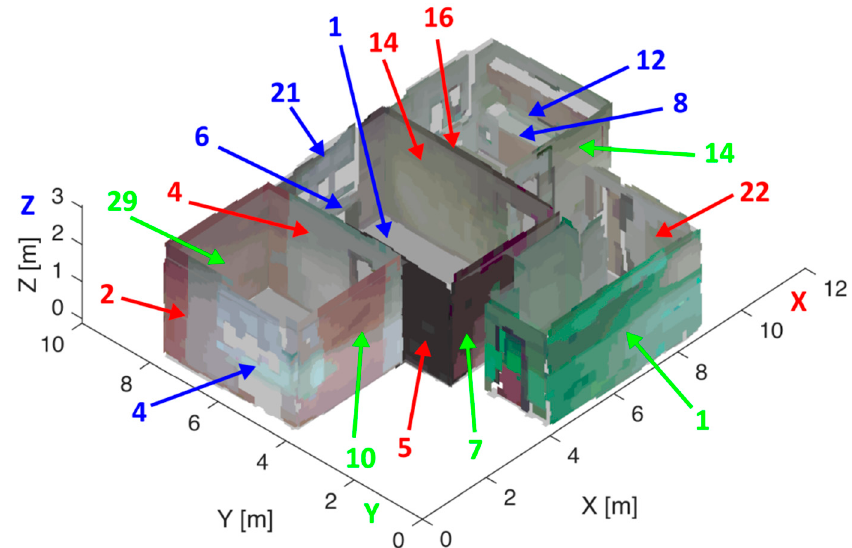
Figure 19. Flat visualization with marked detected planes: red color marks plane detected in X-axis, green color is used for Y-axis, and blue color marks detected planes in the Z-axis.